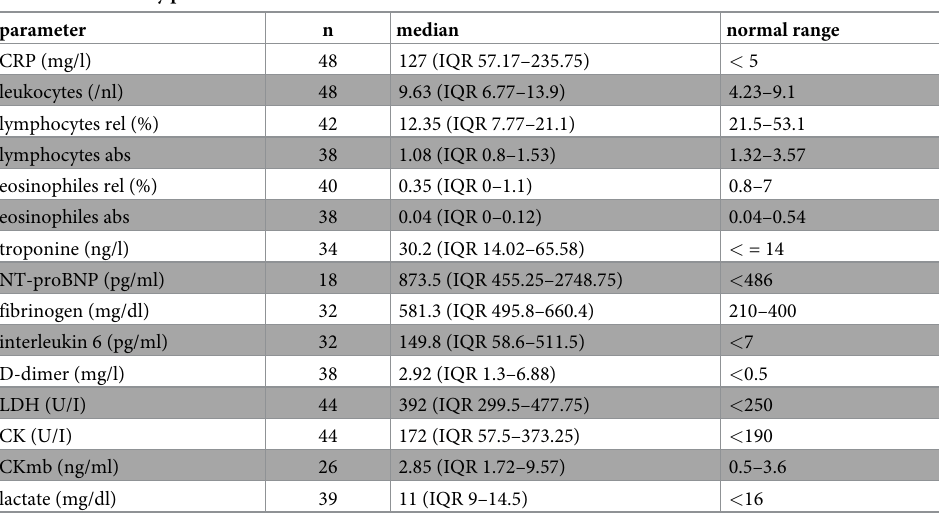
Table 3. Laboratory